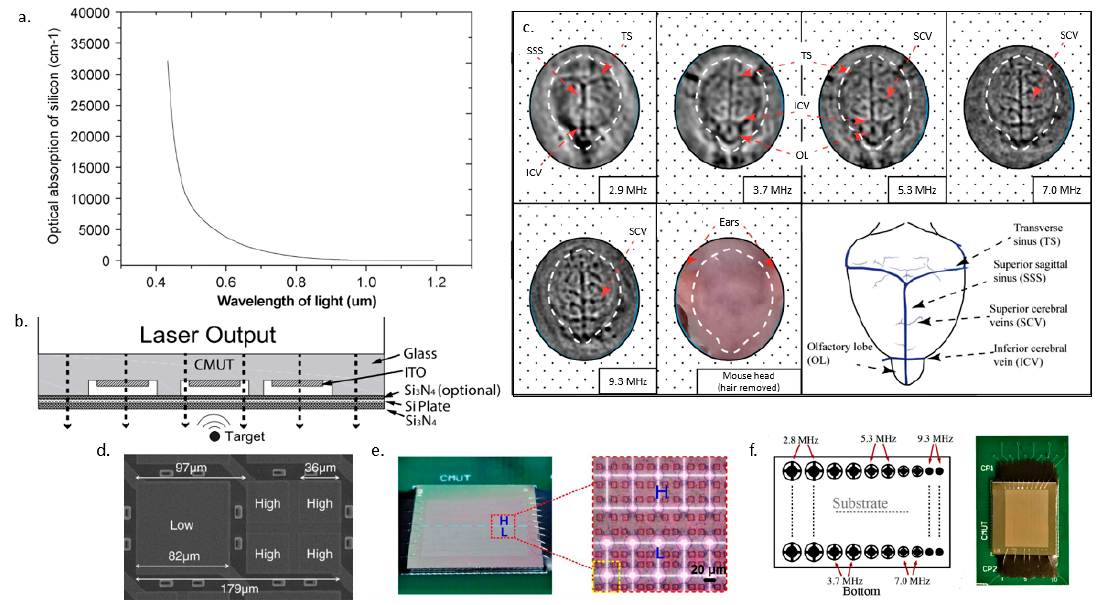
Figure 4. ( a ) Optical absorption of silicon under di ff erent wavelength ( © [2010] IEEE. Reprinted, with permission, from [118]) and ( b ) structure of optically transparent CMUT ( © [2018] IEEE. Reprinted, with permission, from [126]), ( c ) imaging of mouse brain using the di ff erent frequencies of the CMUT ( © [2018] IEEE. Reprinted, with permission, from [130]), ( d ) interlaced CMUT ( © [2017] IEEE. Reprinted, with permission, from [128]), ( e ) multi-band CMUT (Adapted with permission from ref [129], [The Optical Society]), ( f ) monolithic multiband CMUT with five frequencies ( © [2018] IEEE. Reprinted, with permission, from